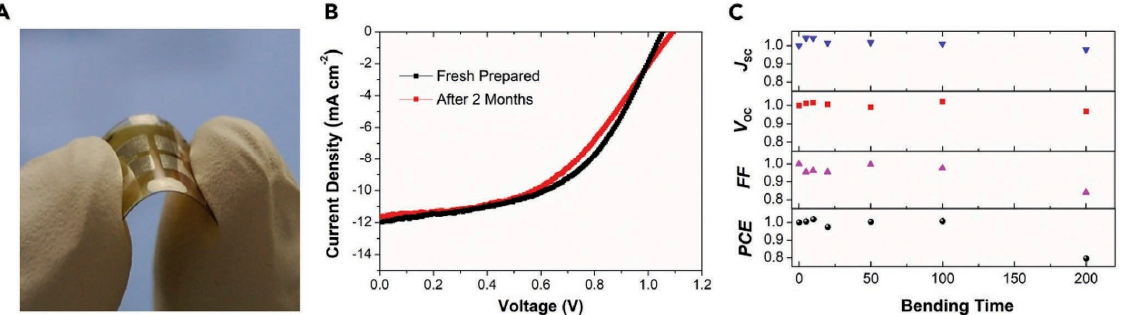
Figure 11. ( A ) An image of a flexible CsPbI 2 Br-based PSC; ( B ) J - V characteristics of the champion device shown freshly prepared and after two months storage without encapsulation; ( C ) Normalized performance parameters of the solar cell after stressing under various bending cycles at a curvature radius of 4.05 mm. Adapted with permission from [99].